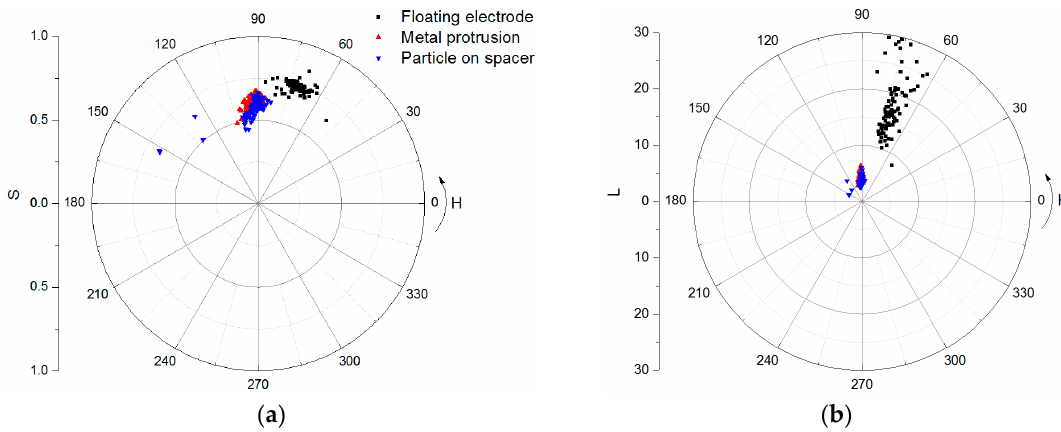
Figure 9. Chromatic parameters distribution of different PD patterns in polar diagram: ( a ) H-S; and ( b ) H-L. Table 4. Classification results of the SVM model in the chromatic space.